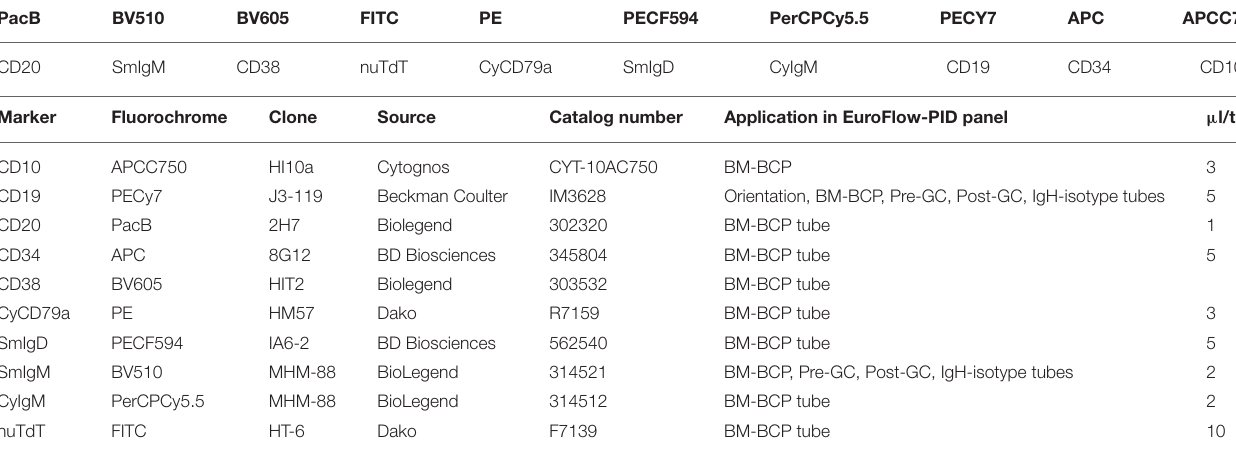
TABLE 3 | Composition of the 10-color BM-BCP tube and technical information on reagents.